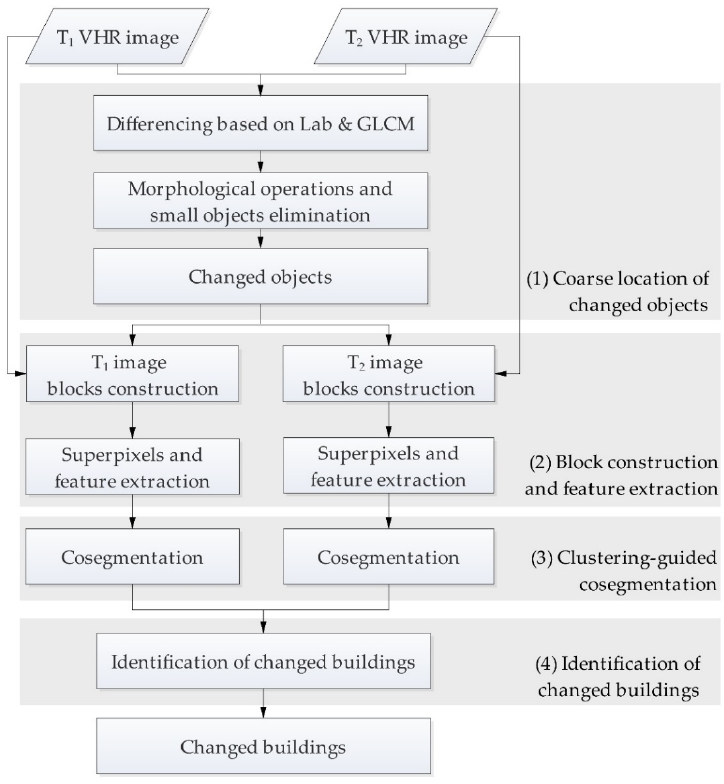
Figure 1. Flowchart of the proposed change detection framework.